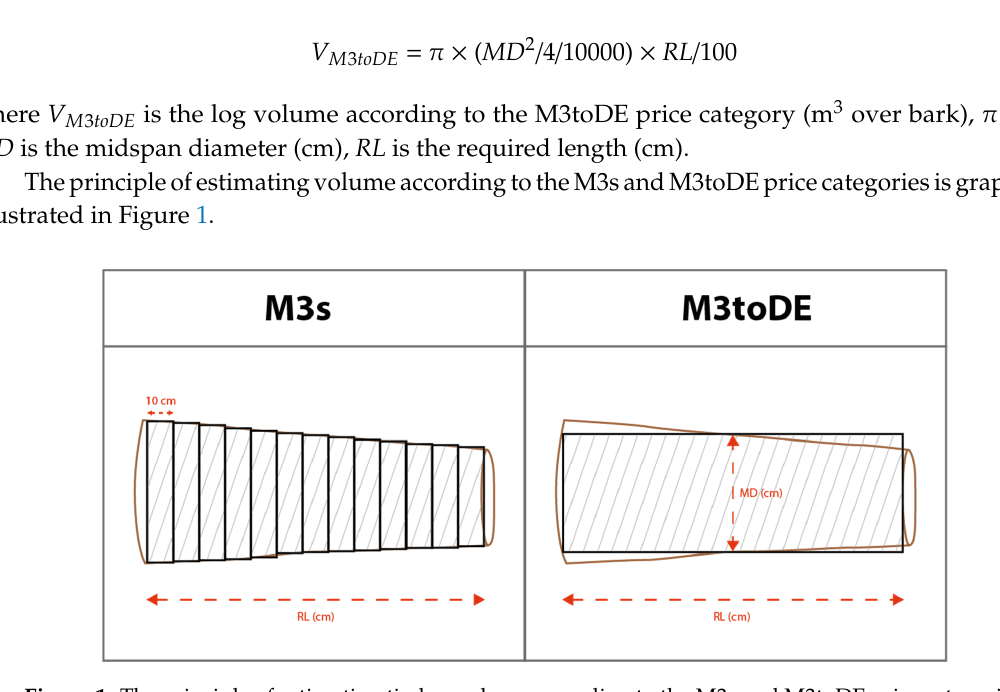
Figure 1. The principle of estimating timber volume according to the M3s and M3toDE price categories. The volume estimated using the M3s price category is based on the estimation of partial volumes of 10 cm long sections, which are then summed. In contrast, the M3toDE price category estimates volume based on the midspan diameter (MD) of the log rounded down to the nearest whole centimeter. Both price categories express the volume of the log using its required length (RL).